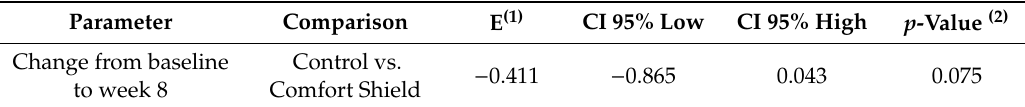
Table 5. CFS: multivariate analysis on change from baseline to week 8—mixed-e ff ects model for repeated measures—PPS population ( n = 84). n used = 79.